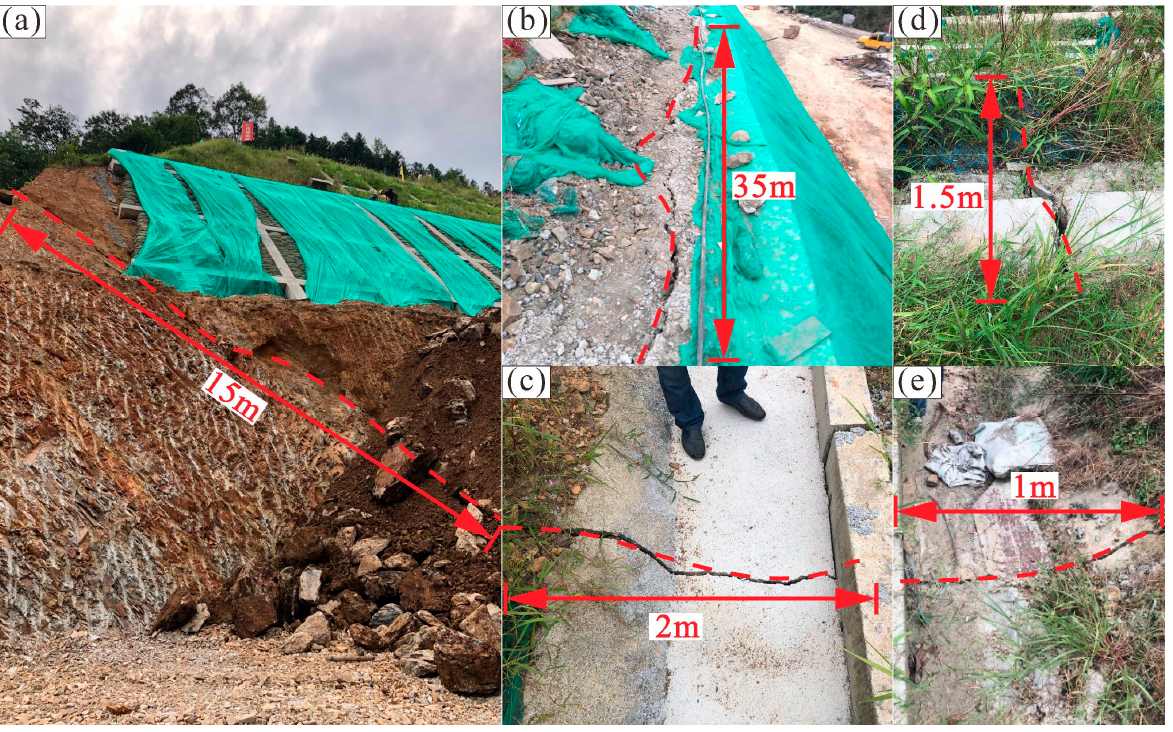
Figure 4. Photos of the Anling landslide deformation at stage 5. ( a ) Crack on the 5th-grade slope. ( b ) Crack on the third bench. ( c ) Crack on the second bench. ( d ) Crack on the first bench. ( e ) Crack on the interception drain of the high-cut slope.